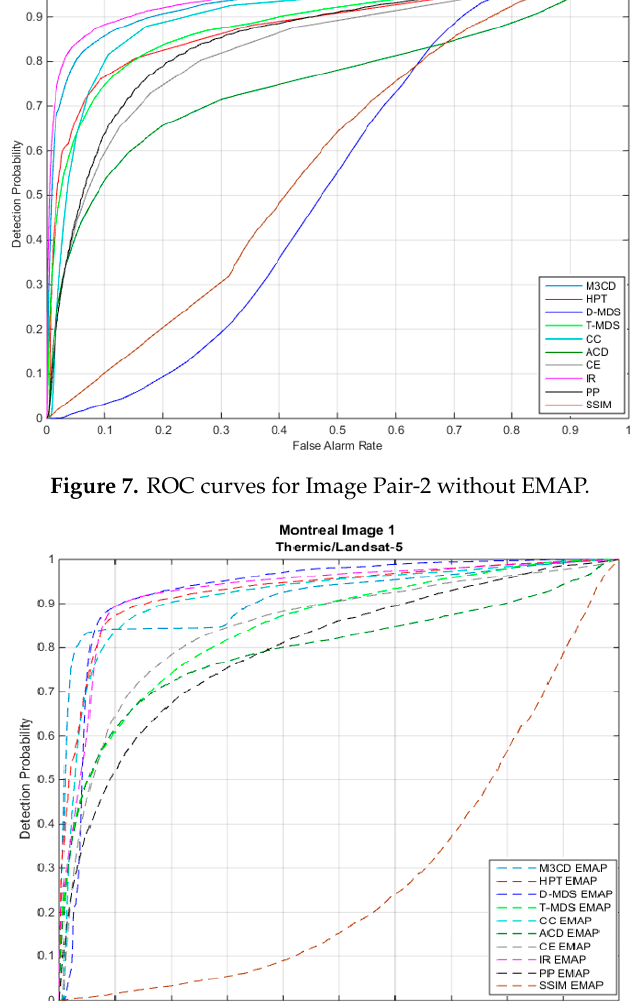
Figure 8. ROC curves for Image Pair-2 with EMAP. Table 3. AUC values and differences between single band and EMAP cases for dataset-2. Bold numbers indicate the best performing method in each column. Method